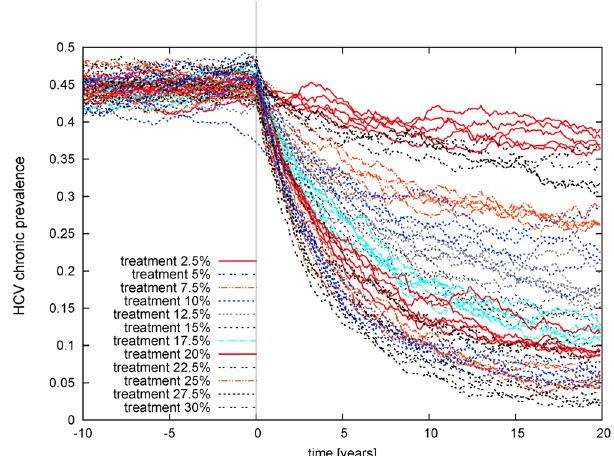
Figure 3. Prevalence of chronic infection over time following the introduction of treatment at different levels ranging from 2.5% to 30% on the same ec-network as in Fig. 2. The system is at equilibrium before treatment is introduced at time 0. Results of individual simulations are